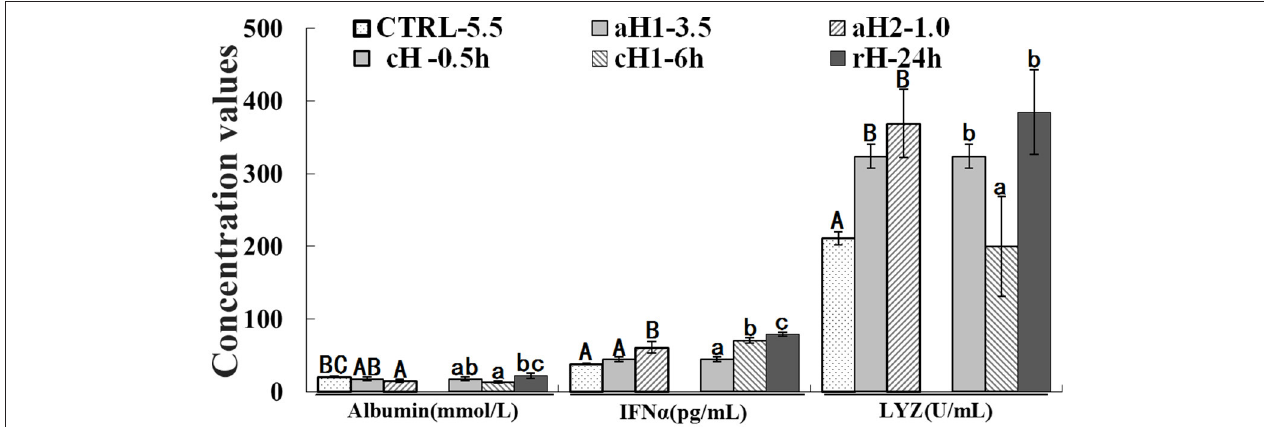
FIGURE 2 | Serum albumin, interferon alpha (IFN α ) and lysozyme (LYZ) levels in M. amblycephala after hypoxia treatment. Three different DO level groups are individually analyzed and indicated with capital letters, while three hypoxia time condition groups are also separately analyzed and showed with lowercase letters. Different letters above bars represent significant difference ( p < 0.05), and the same letters above bars indicate no significant difference. Values are mean ± S.D.; N = 5 for every